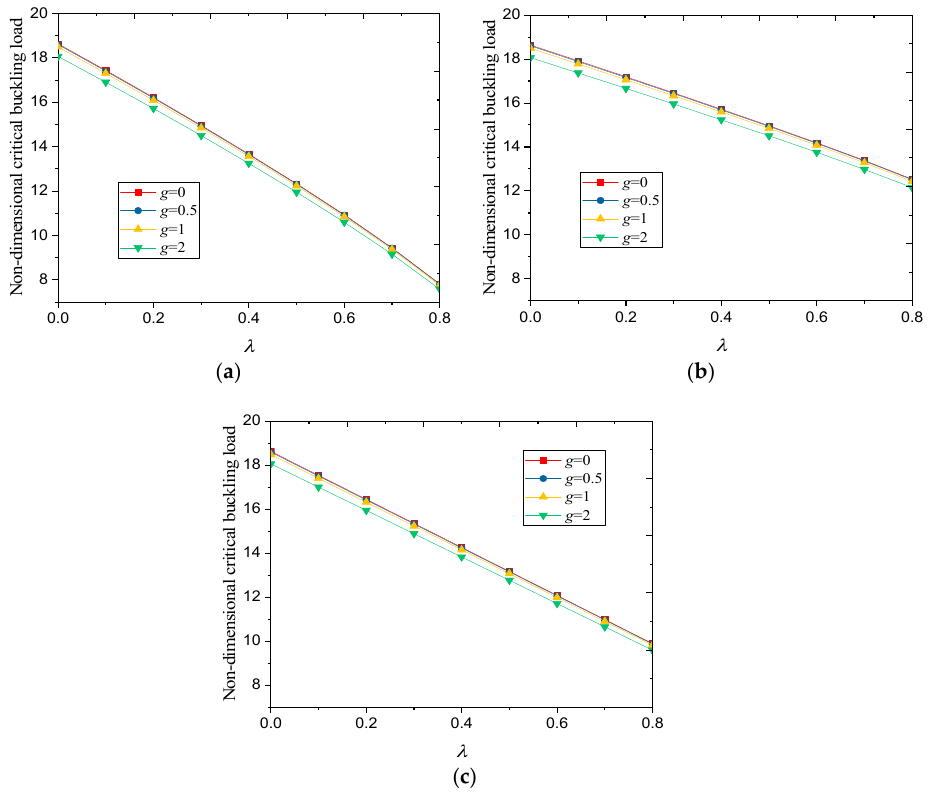
Figure 6. Variation of non-dimensional critical buckling load with a porosity coefficient λ ( m = n = 1, h = 5 nm, l a = l b = 50 nm, ζ = 1): ( a ) UD, ( b ) NUD1, ( c ) NUD2.